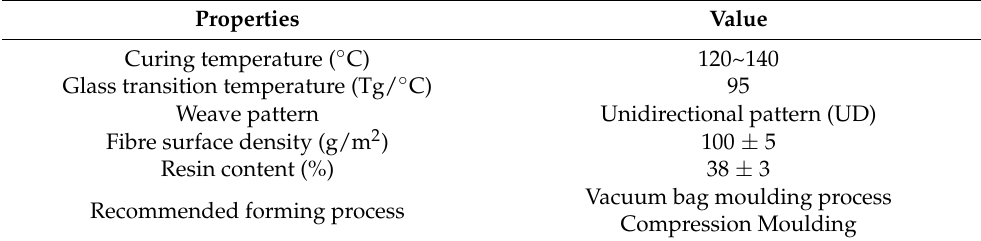
Table 1. Several parameters of T700 carbon fibre prepreg.